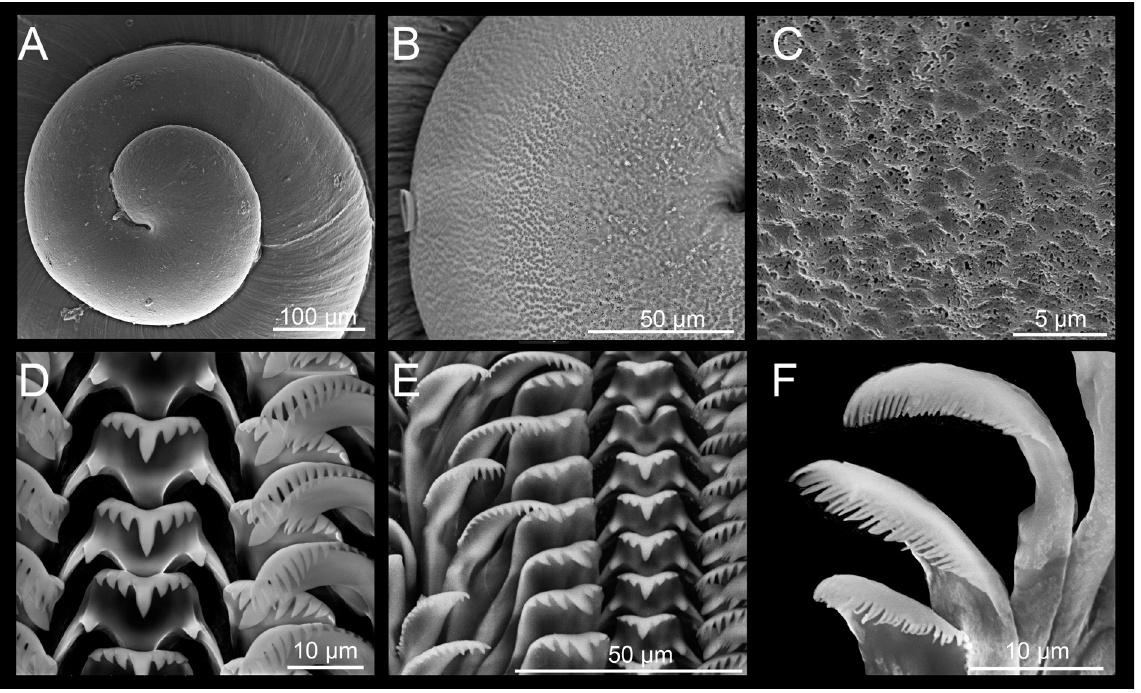
Fig. 9. Protoconch and radula of Mercuria tachoensis (Frauenfeld, 1865). A–C . Fonte dos Amores Spring, Coimbra, Portugal. A . Protoconch. B . Details of the protoconch. C . Protoconch microsculpture. D–E . Stream near the beach in Bidart, France. D . Detailed view of the central and lateral teeth. E . Detailed view of the outer marginal teeth. F . Spring at Jardim da Sereia, Coimbra,